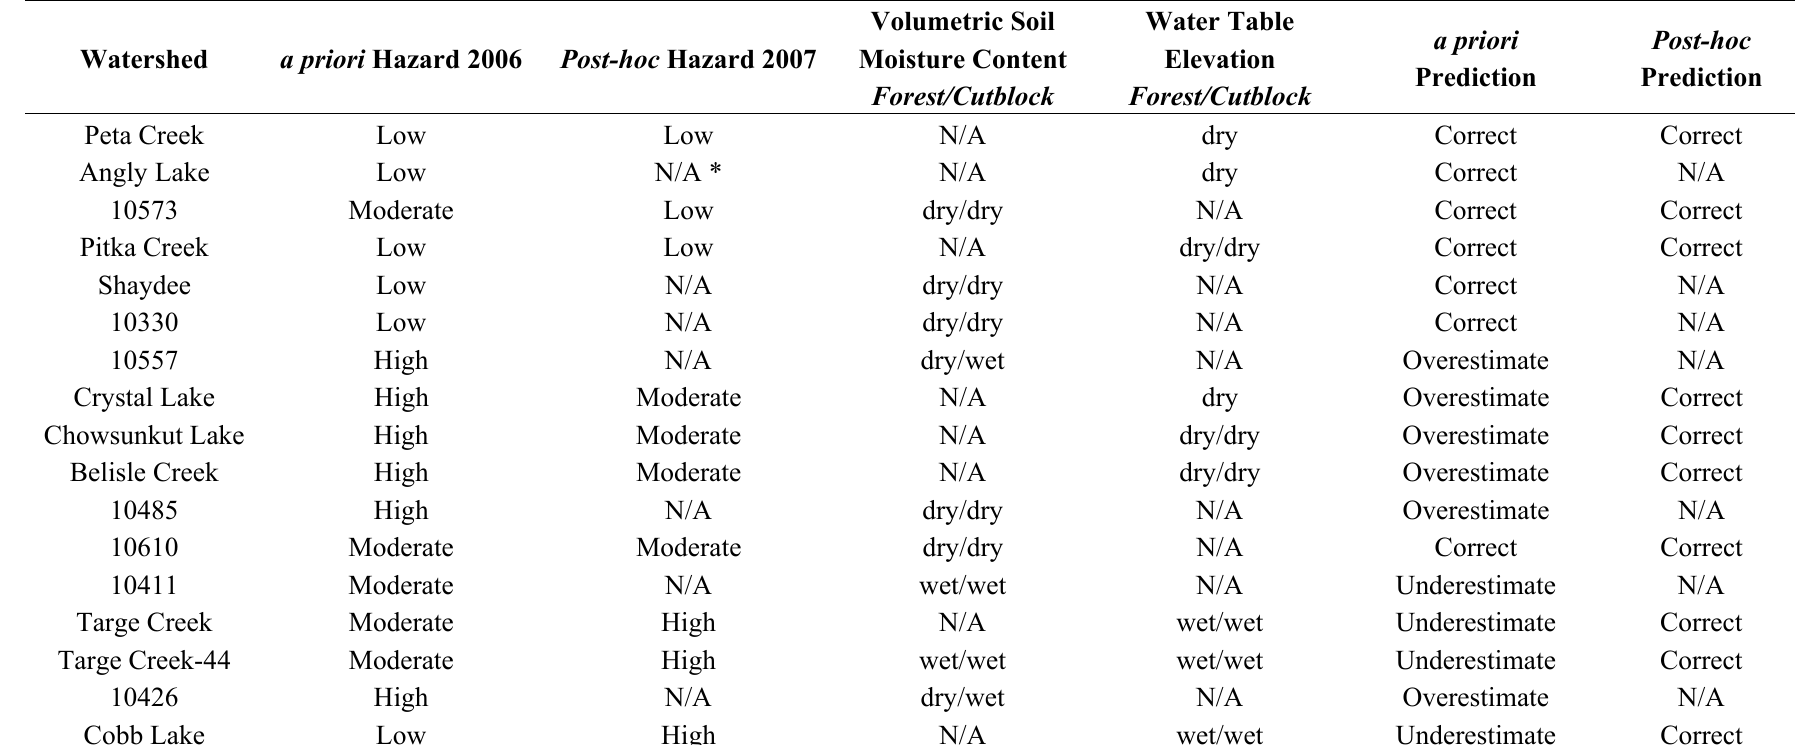
Table 7. Watershed hazard prediction for a priori and post-hoc assessment, field data verification summary for volumetric soil moisture and water table elevation along with comments on whether the prediction was correct, over- or underestimated. Table values identify whether the average condition was wet or dry during the summer months of 2007, the wettest summer during the sample period. Post-hoc hazard prediction and hazard scores for 2007 are not included for those watersheds used to generate the post-hoc